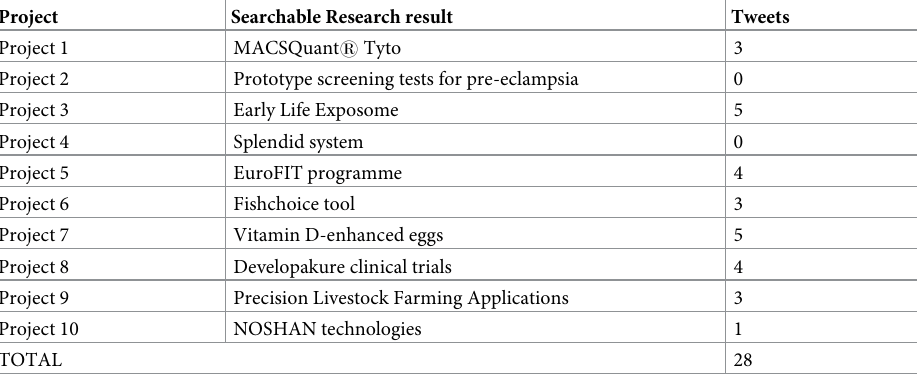
Table 5. List of searchable research results–Strategy